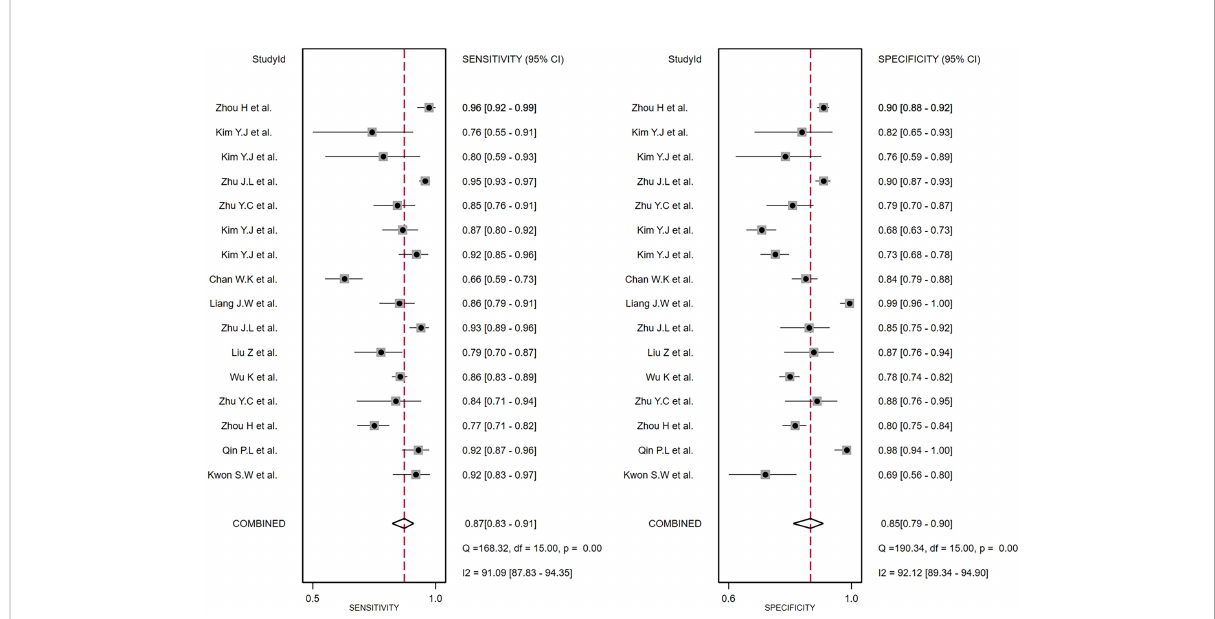
FIGURE 3 The forest plot of sensitivity and speci fi city for diagnosing thyroid nodules. Horizontal lines illustrate 95% con fi dence intervals of the individual studies.